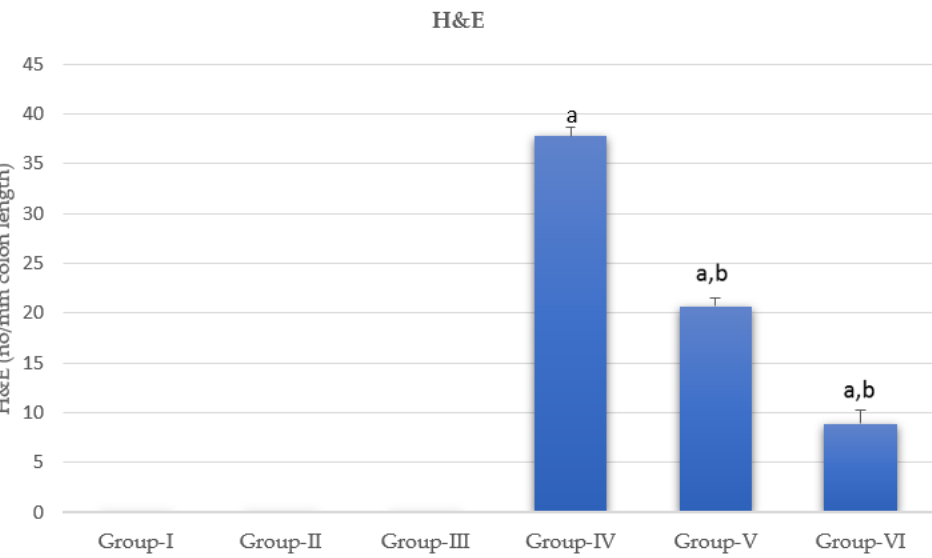
Figure 6. Photomicrographs of a normal colon section of mice stained with hematoxylin and eosin; ( A ): Colon of Group I animal showing normal intestinal crypts lined with columnar epithelium rich with goblet cells (arrows), H&E, ×200, bar = 50 μ m; ( B ) and ( C ): Colon section of mice in Group II showing normal intestinal glands (arrows), H&E, ×200, bar = 50 μ m; ( D ): Colon section of mice in Group III showing normal intestinal crypts (arrows), H&E, ×200, bar = 50 μ m.